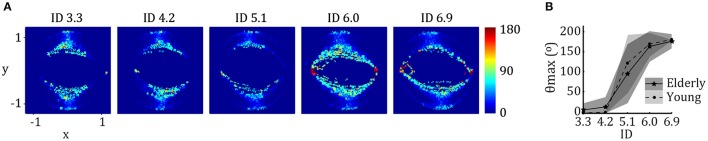
(A) Reconstructed angle diagrams as a function of ID averaged across participants. The horizontal axes represent normalized position (x); the vertical axes normalized velocity (y). The color coding (right side of the panel) represents the maximum angle in degrees between adjacent vectors. Red areas indicate the existence of locally opposing angles and imply the presence of a fixed point. Its absence implies the existence of a limit cycle. (B) The maximum angle in degrees between adjacent vectors as a function of ID averaged across participants (θmax) for both young (light gray and dotted line) and older (dark gray and solid line) adults. The horizontal axis represents ID; the vertical θmax (degrees). Error bars denote 1 standard deviation.